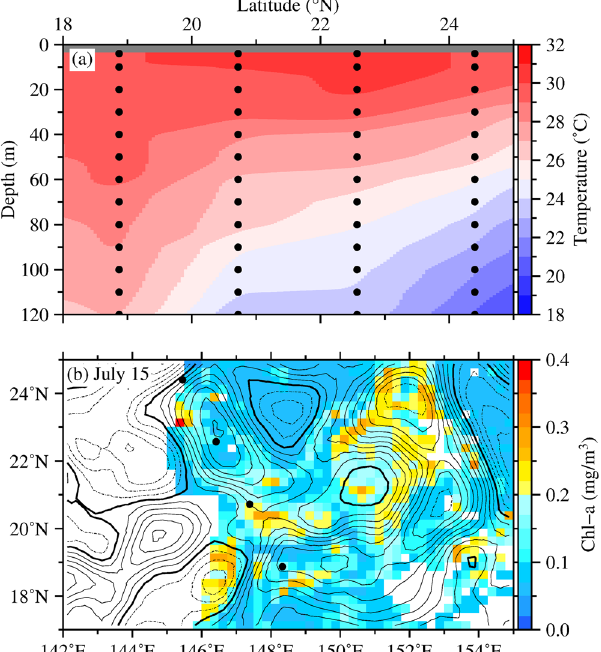
Figure 9. ( a ) Contour plot of temperature measured by CTD H9TO on July 15. Black circles indicate the actual depth of each observation. ( b ) SSHAs (contour interval: 4 cm, dashed: negative, solid: positive, bold solid: zero) overlaid on Chl (colors, units in mg/m 3 ) on July 15. Black circles indicate the locations of CTD H9TO. This figure was generated using open source Generic Mapping Tools 33 (Ver. 5.3.0